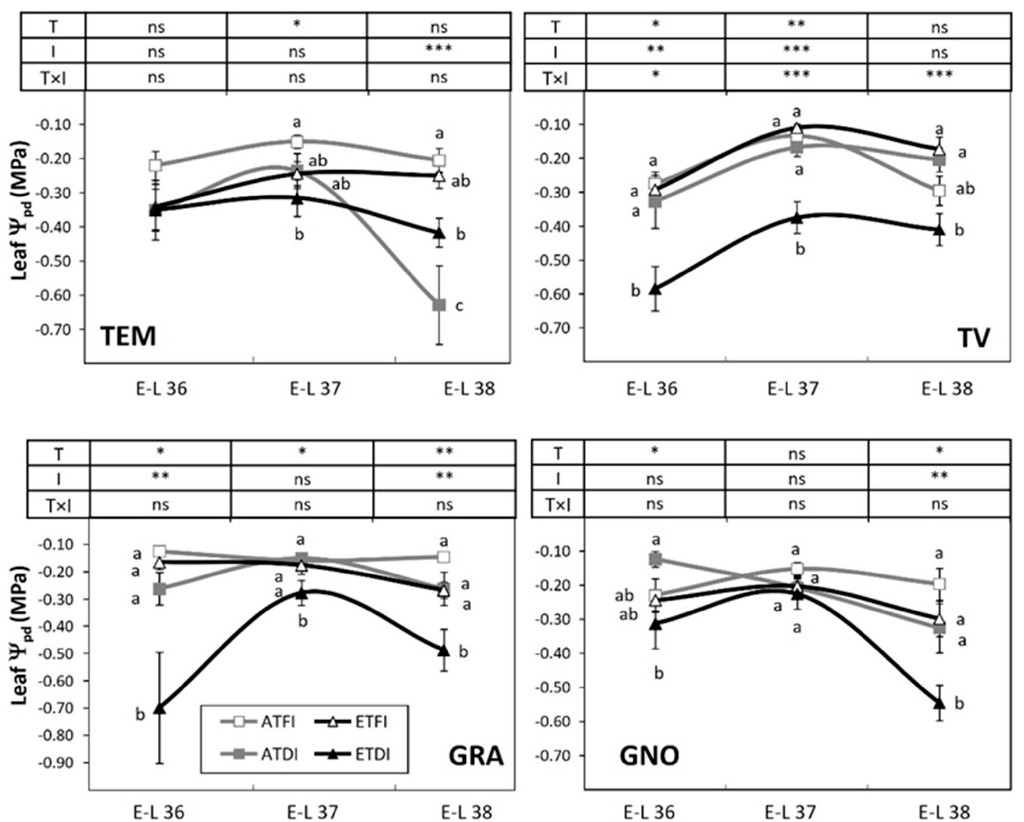
Figure 2. Pre-dawn leaf water potential ( Ψ pd ) recorded at three stages of berry ripening in fruit-bearing cuttings of ancient wine grape genotypes grown either at ambient (AT) or elevated temperature (ET) and subjected to different irrigation regimes (FI, full irrigation; DI, deficit irrigation). Values are means ± S.E. ( n = 5). Means within each stage followed by the same letter do not differ significantly ( p > 0.05) according to Duncan’s test. Two-way analyses of variance (ANOVA) assess the main effect of the temperature (T), irrigation (I), and their interaction (T × I). Significance of the ANOVA: * p < 0.05; ** p ≤ 0.01; *** p ≤ 0.001; ns, not significant ( p ≥ 0.05). The variety labels can